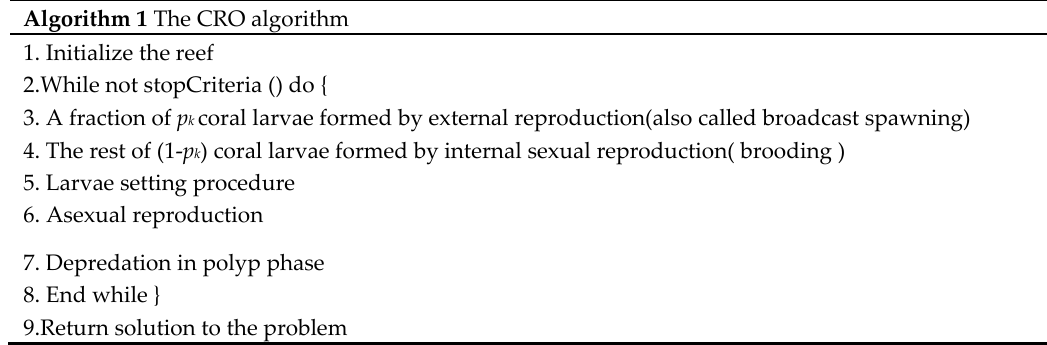
Algorithm 1 The CRO